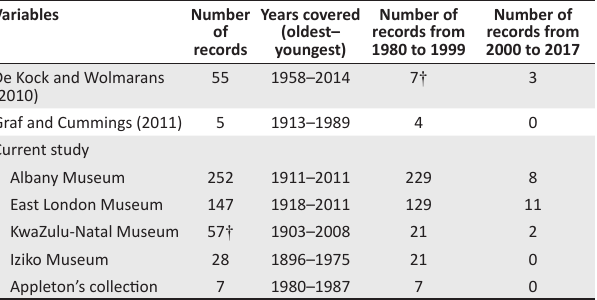
FIGURE 1: Examples of empty shells of Unio caffer in the collection at Albany Museum. TABLE 1: Numbers of records in the reviewed collections and the years in which they were accessed.